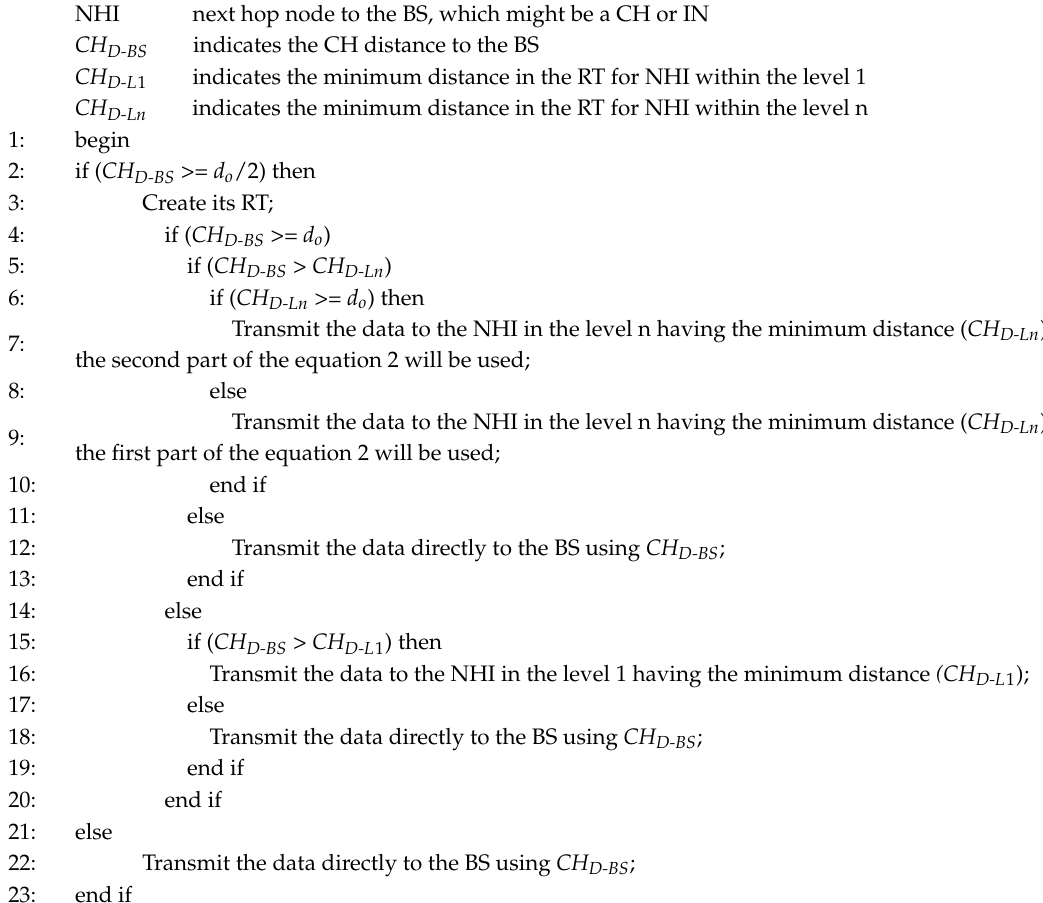
Algorithm 3: The inter-cluster routing for